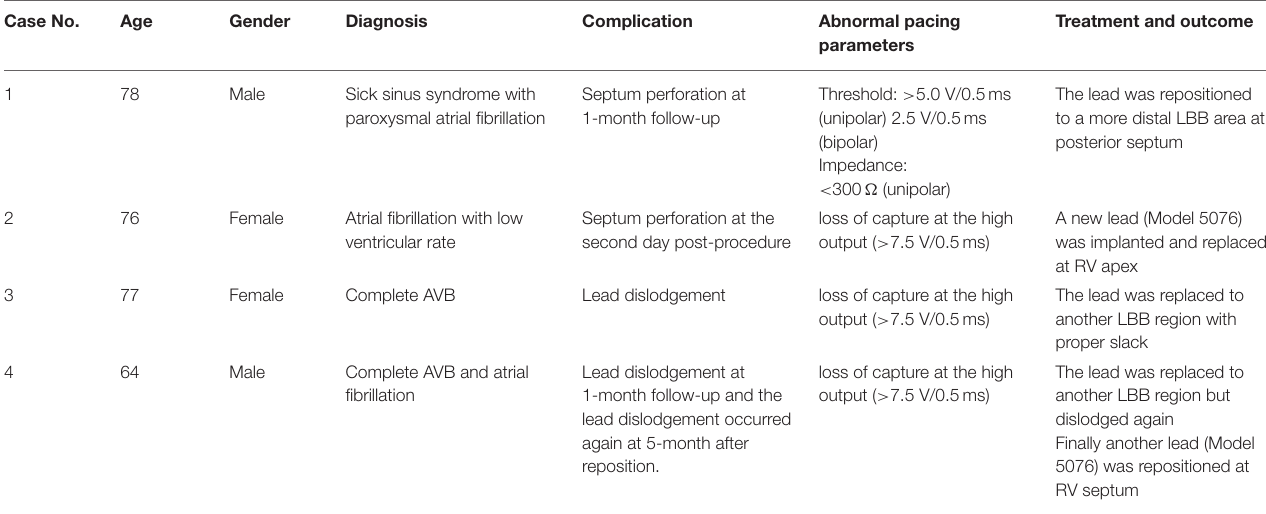
TABLE 2 | Septum perforation and lead dislodgement cases. Case